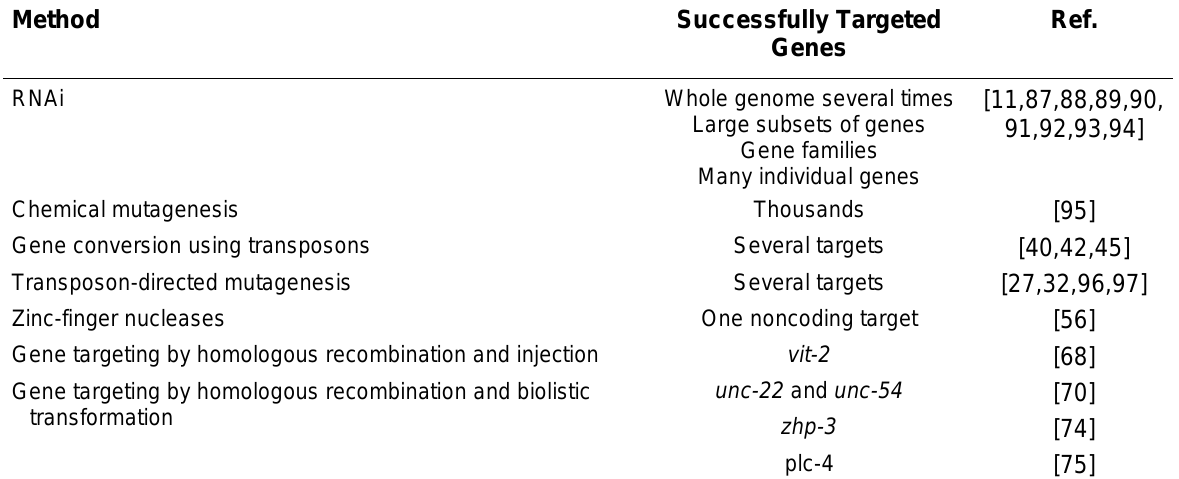
Genes Targeted by Different Methods of Reverse Genetics in C.